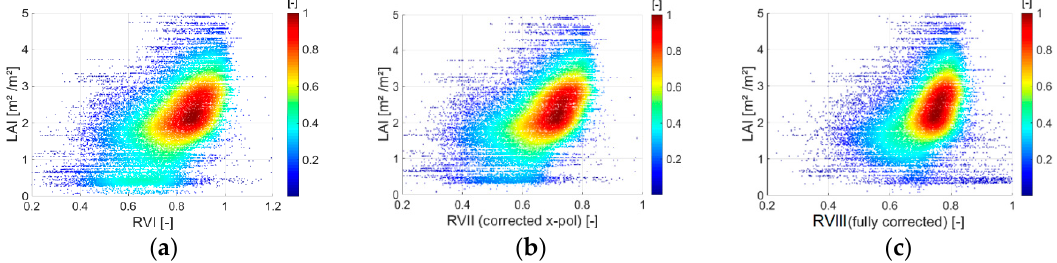
Figure 13. Correlation for the combined study areas between: ( a ) RVI [-]; ( b ) x-pol corrected RVII [-]; ( c ) fully corrected RVIII [-] and Leaf Area Index (LAI) [m 2 /m 2 ] from Myneni et al. [24].